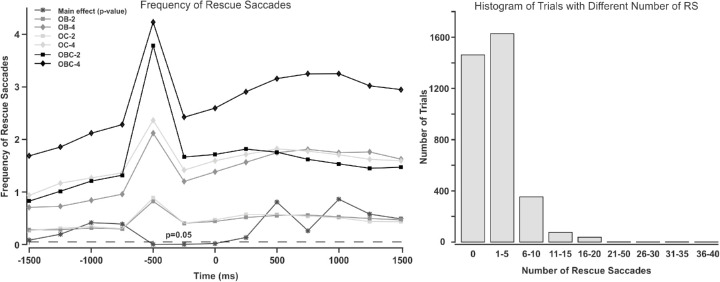
The right panel shows the histogram of the number of trials with RSs. The left panel depicts the p value of the main effect of RS (gray line with stars) in target accuracy in different time windows (a 1-second window was used, 500 ms to either side from the center of window). Lines with squares and diamonds show the frequency of RSs for the different occlusion conditions in each time window. OB = object-object occlusion; OC = object-occluder occlusion; OBC = object-object + object-occluder occlusion. Error bars show standard error of mean.